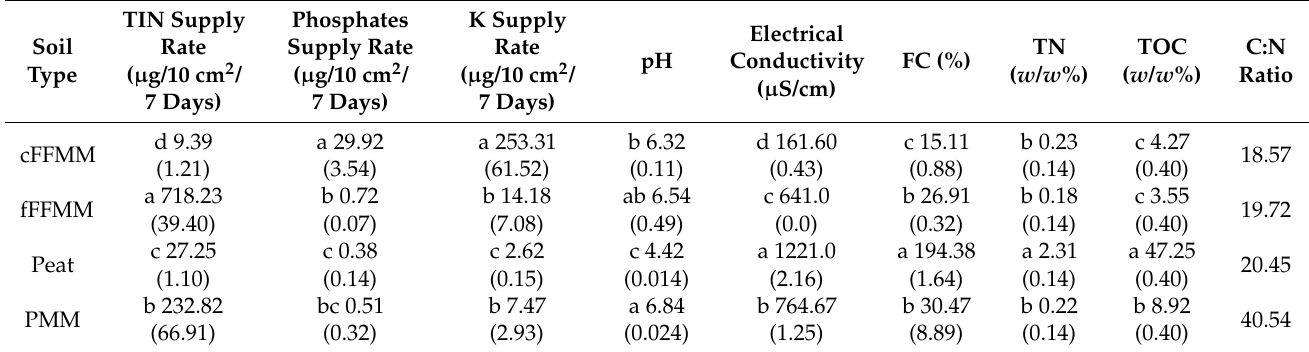
Table 1. Soil nutrients and chemical properties. Values are mean and standard error. Letters indicate similarities among soils ( p > 0.05). Total inorganic nitrogen, TIN; total carbon, TC; total nitrogen, TN; total organic carbon, TOC. Soil types: coarse forest floor-mineral mix, cFFMM; fine forest floor-mineral mix, fFFMM; peat; peat-mineral mix,